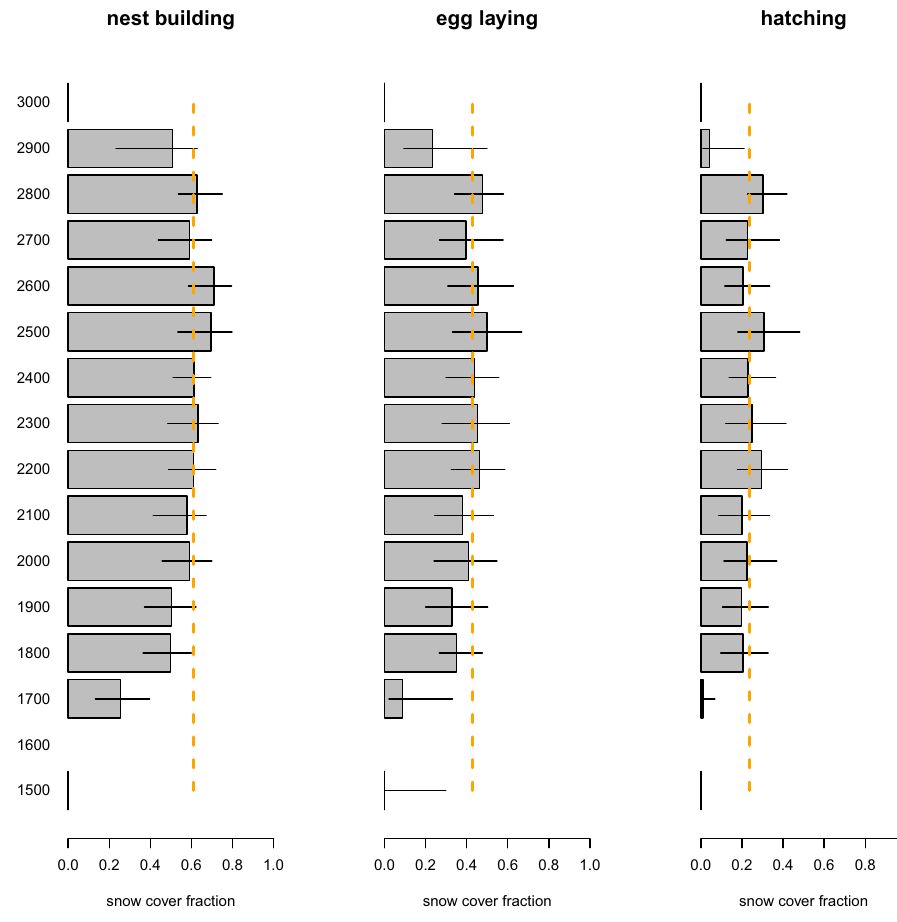
Figure 1. Mean snow cover fraction per elevation during nest building, egg laying and hatching. Error bars range from average earliest to average latest possible dates per event, orange lines (dotted) indicate mean snow cover fraction per